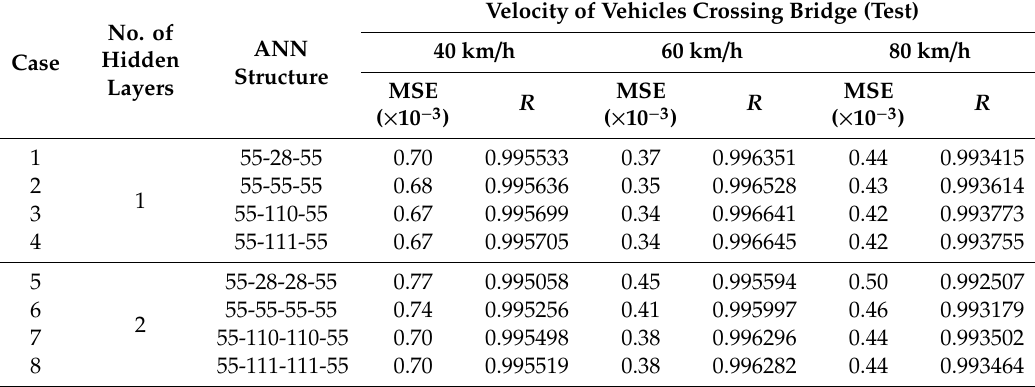
Figure 10. Test results for 40 km/h by ANN structure. Table 6. Test results by ANN structure